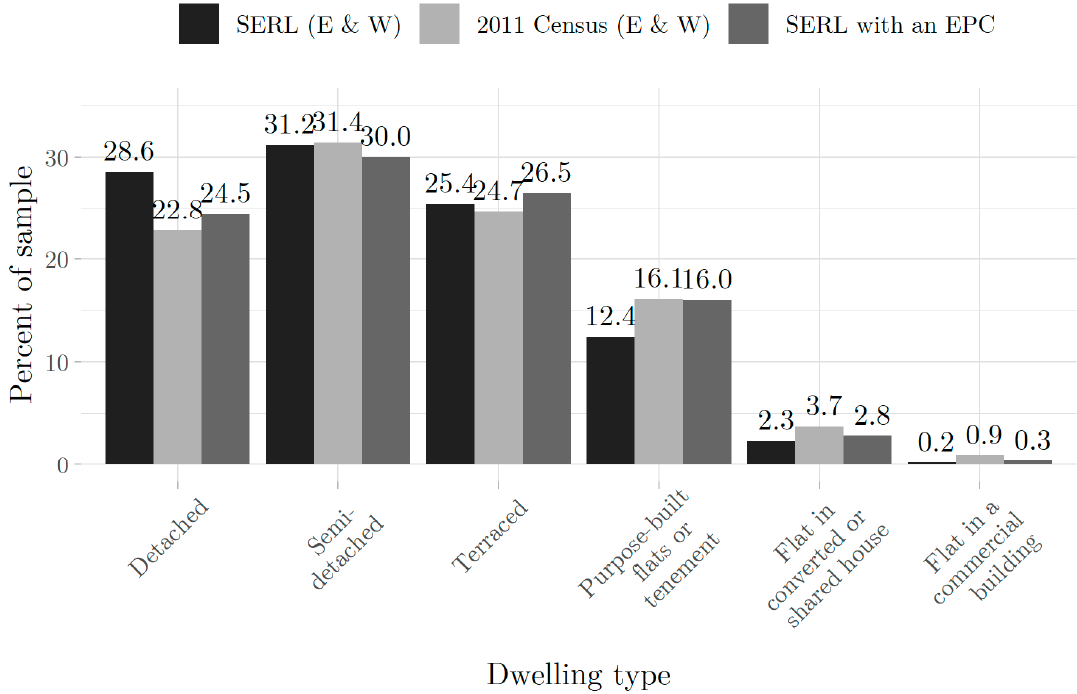
Figure 24. Dwelling type among SERL survey respondents (counts rounded down to the nearest 20 for statistical disclosure control), the 2011 Census respondents and SERL survey respondents with an EPC (all England and Wales only).